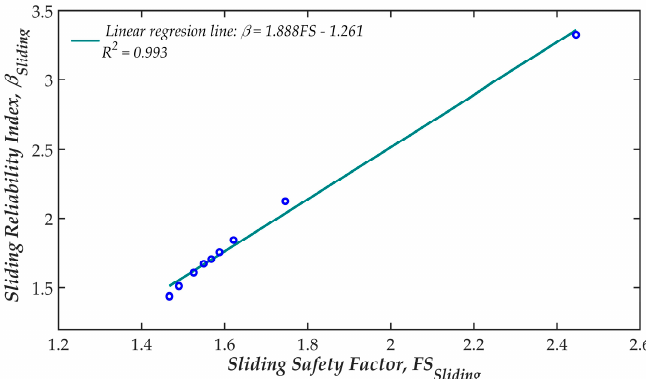
Figure 4. Relationship between the reliability index and safety factor for sliding failure mode.